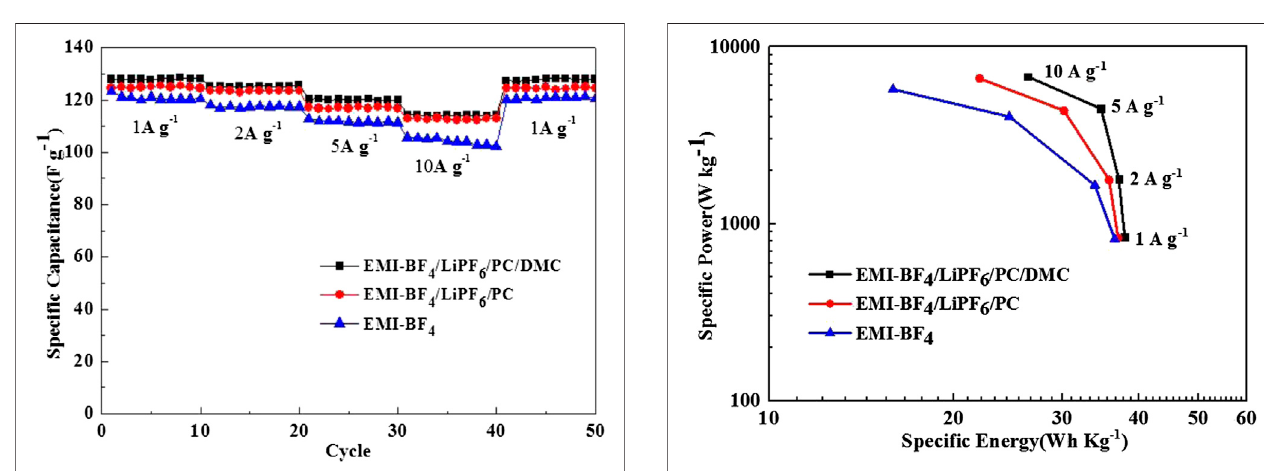
FIGURE 7 | Ragone plots for the EDLCs in various electrolytes. The indicated speci fi c energy and speci fi c power refer to the total mass of the active materials on both